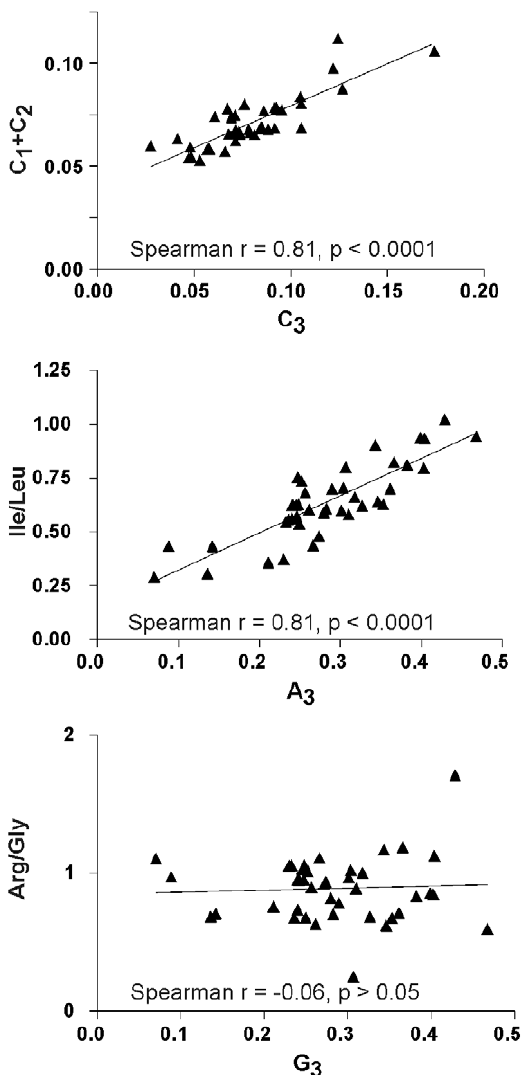
Figure 4. Correlation between sequence content at synony- mous positions and sequence content at non synonymous positions/encoded protein content. Correlation between C content at codon positions 1 + 2 vs. 3 (A); ratio of isoleucine to leucine to third- position A content (B); ratio of arginine to glycine content to third- position G content (C) in 29 animal RNA viruses (Table